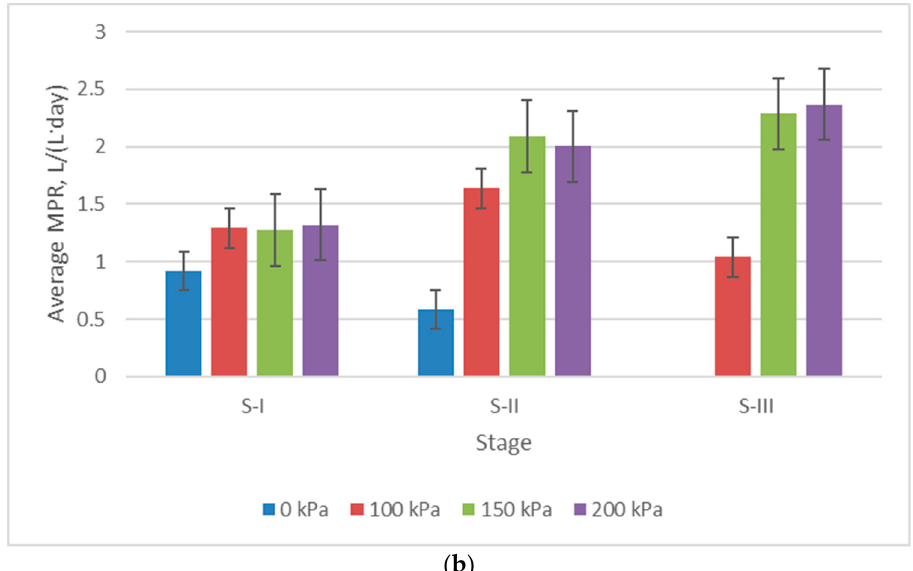
Figure 5. Dynamics of methane production rate (MPR) ( a ) and its average value ( b ) depending on the overpressure and HRT in digesters.